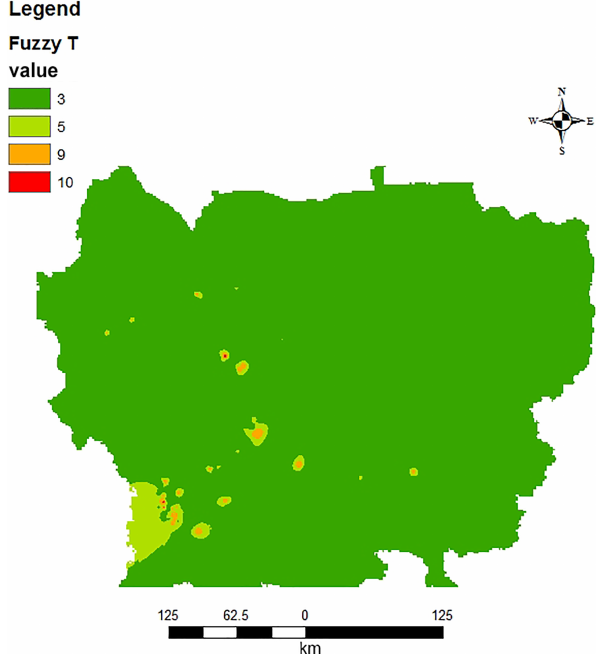
Figure 10. Fuzzy concept topography (or slope) distribution map.